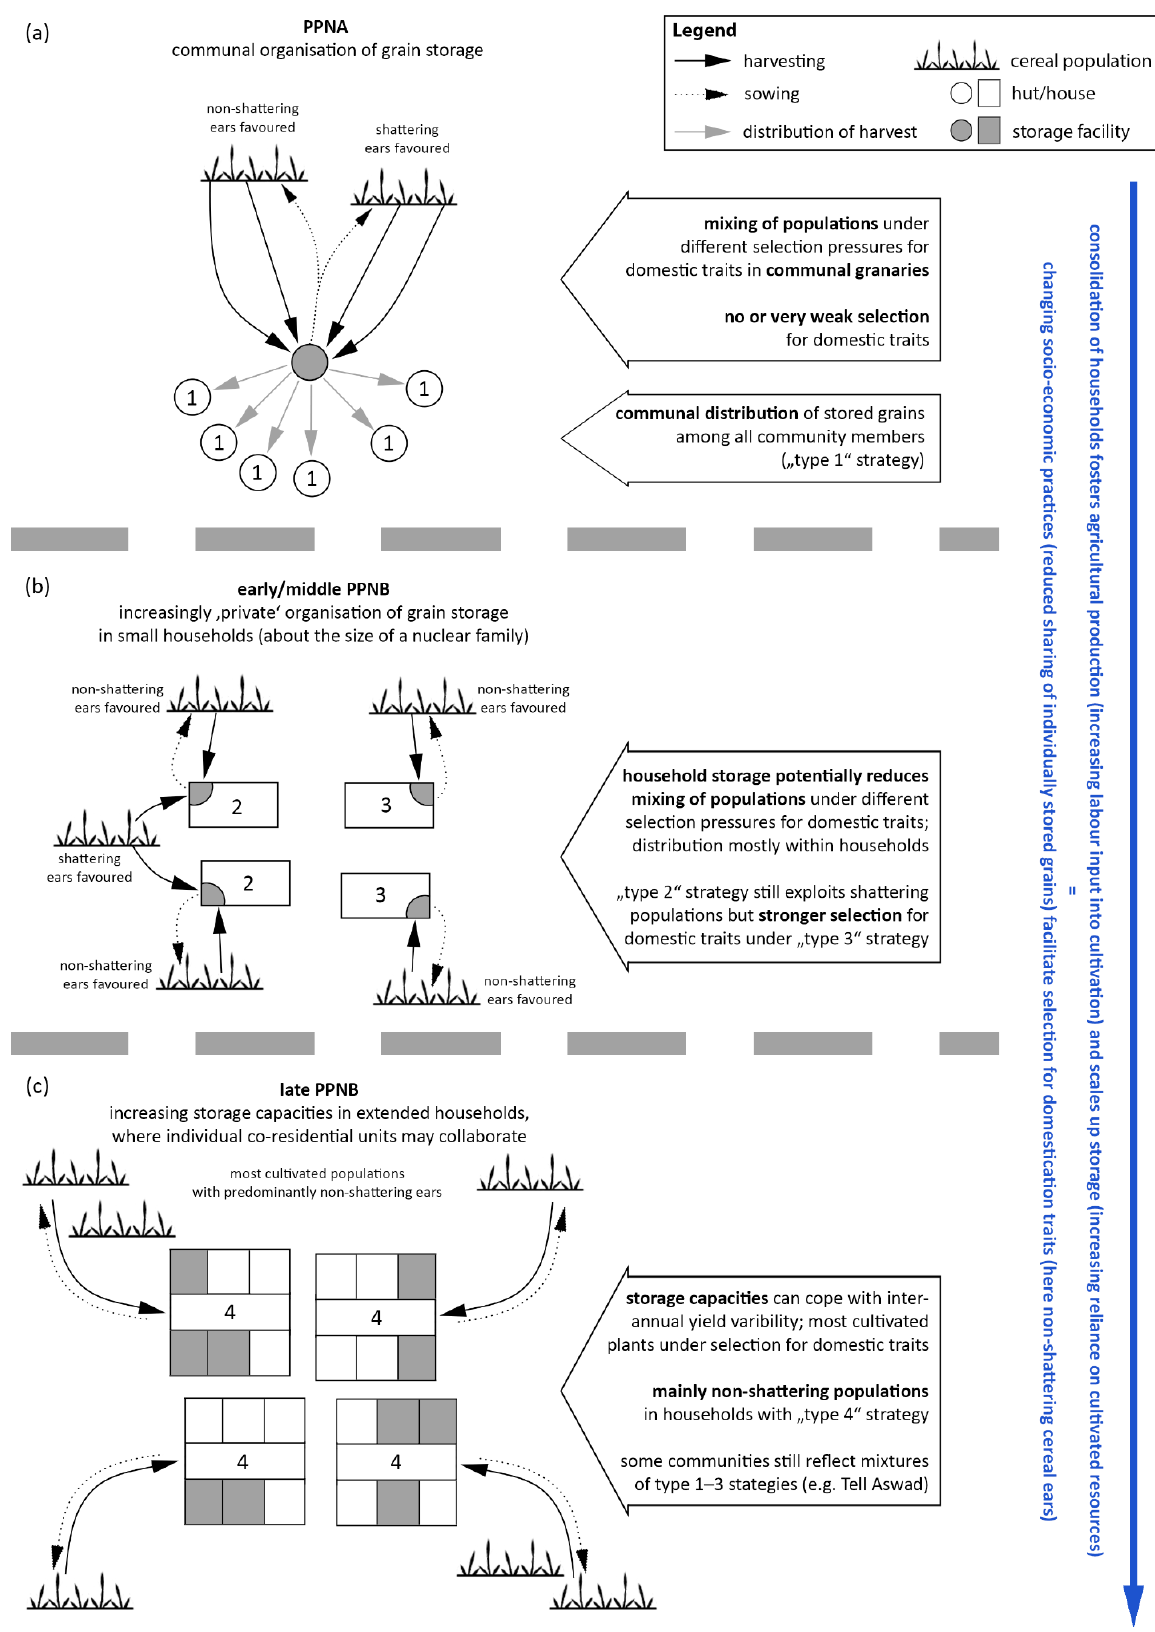
Figure 3. Idealised model for the development of household-centred storage and cultivation systems throughout the ( a ) PPNA, ( b ) early/middle PPNB, and ( c ) late PPNB, and their hypothetical effects on selection for non-shattering cereal ears.